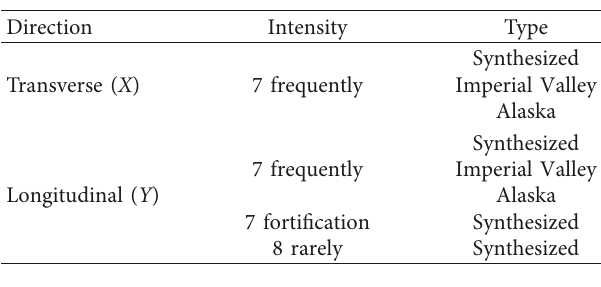
Figure 11: Earthquake acceleration time-history curve of intensity 8 rarely of synthesized (longitudinal input). Table 3: Seismic input.